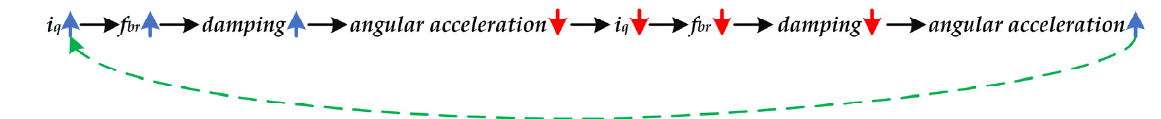
Figure 3. Automatic current ‐ constrained mechanism of barrier function f br .